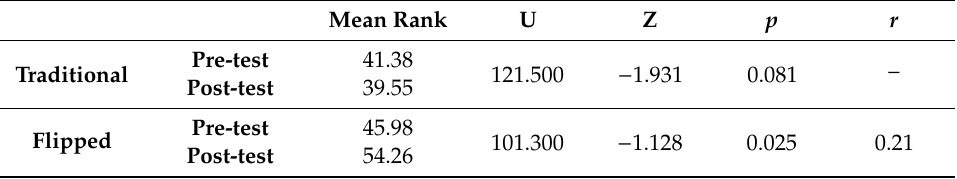
Table 7. Mann–Whitney U test for the learning autonomy